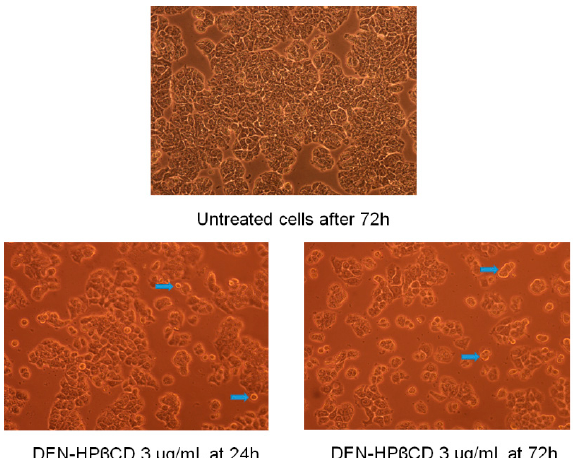
Figure 2. The morphological changes of HT29 treated cells with (3.125 and 6.25 µg/mL) of DEN dissolved in dimethyl sulfoxide (DMSO) for 24 and 72 h. Note: blue arrows indicate apoptotic cells (200×).